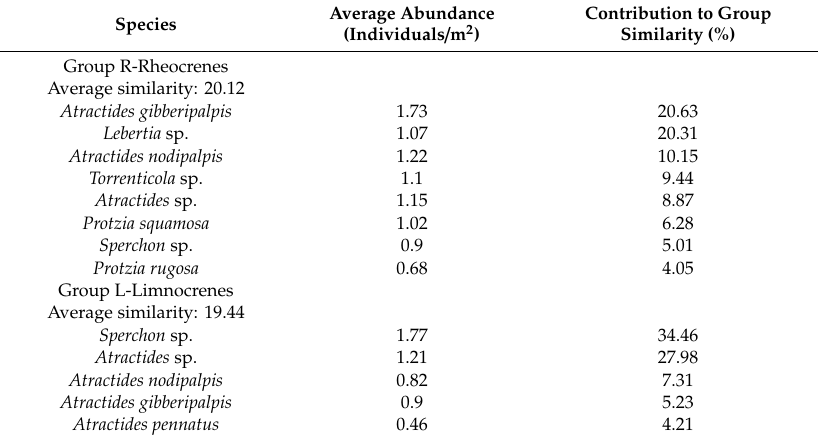
Table 2. Results of the SIMPER analysis based on water mite assemblages from sites of di ff erent spring morphology: R-Rheocrenes and